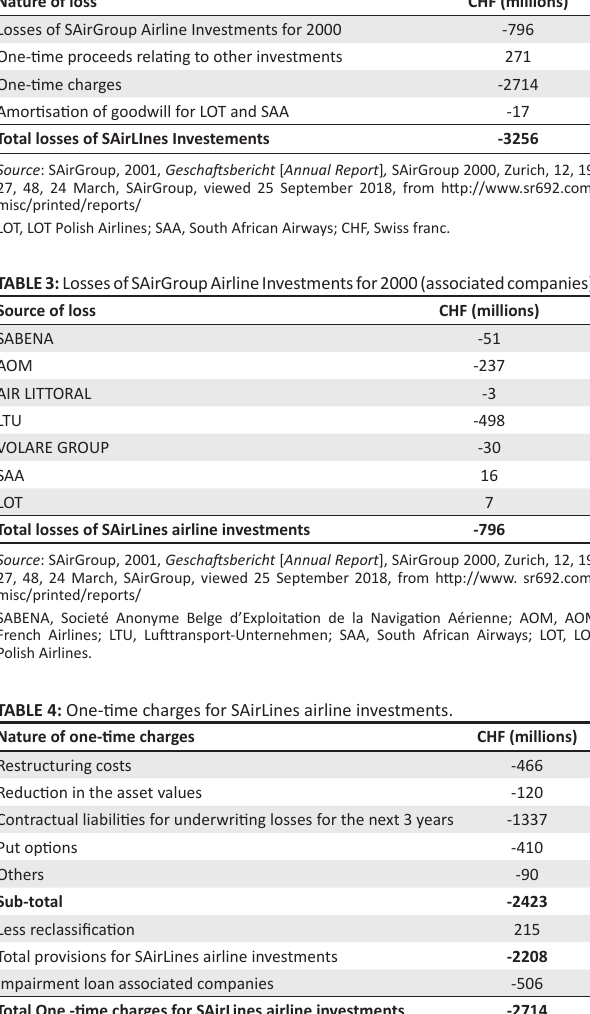
TABLE 2: Analysis of losses of SAirLines Investments included in SAirGroup losses. Nature of loss